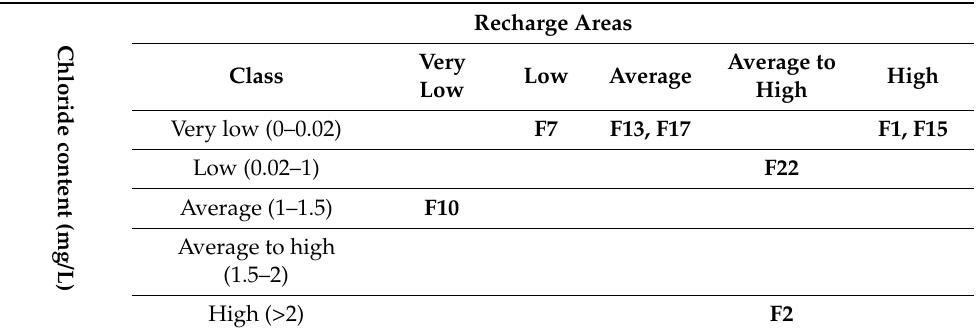
Table 9. Correspondance matrix between chloride contents and recharge